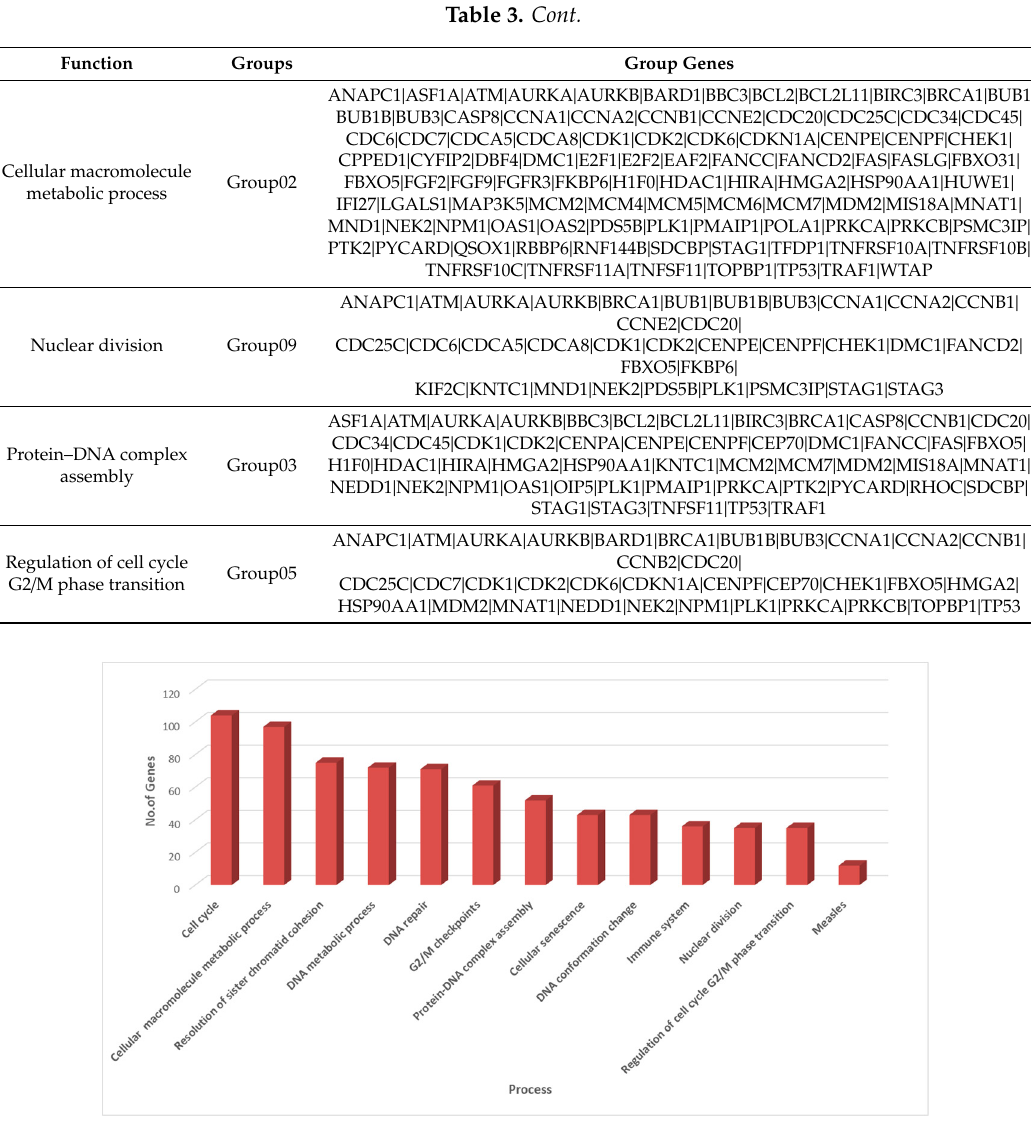
Figure 11. Representation of the pathways enriched and the total number of genes associated with them.